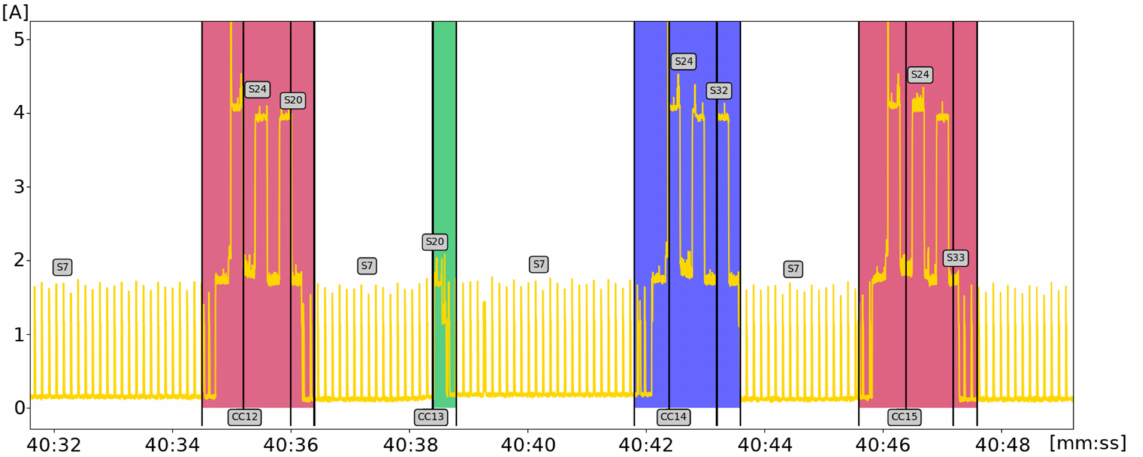
Figure 1. Example of time series for IoT device.